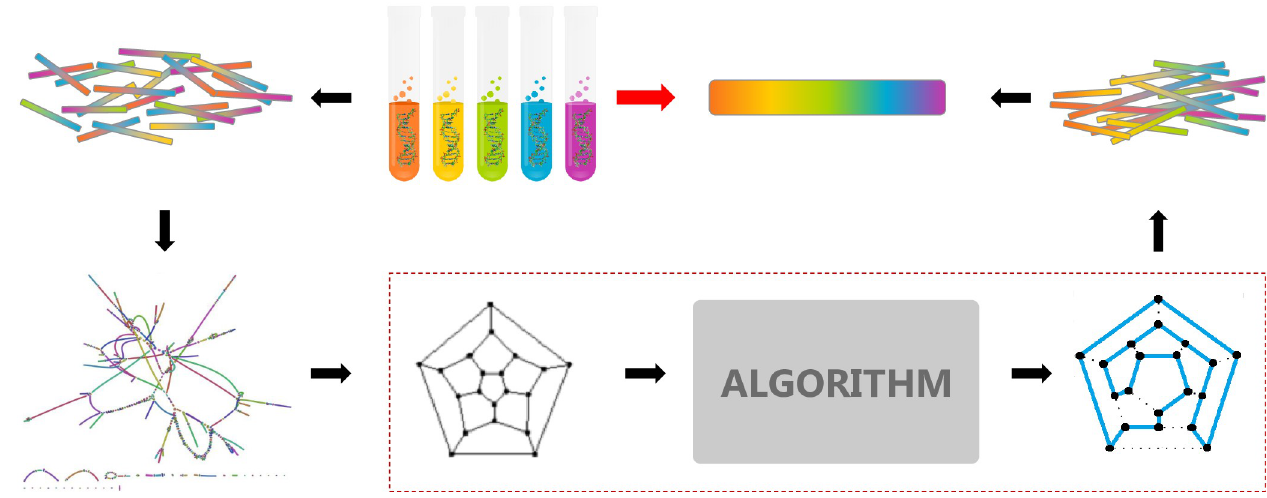
Fig 2. Overlap-layout-consensus genome assembly